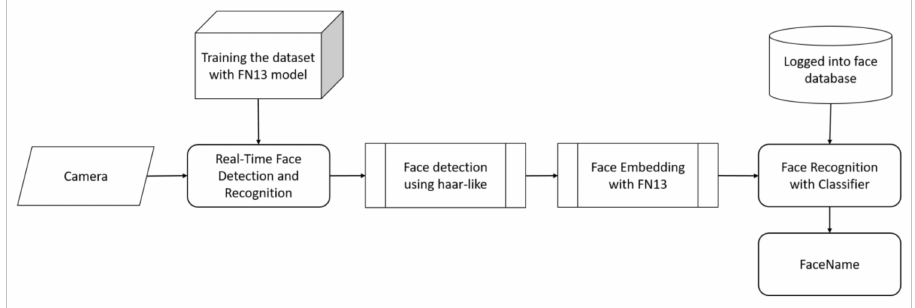
Figure 10. Processing flowchart with FN13 on a real-time face recognition embedded system.